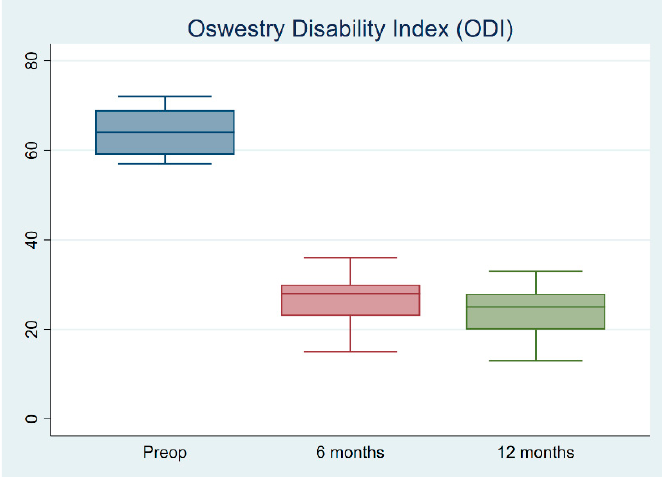
Figure 5. The Oswestry Disability Index (ODI) significantly improved 6 months after surgery.